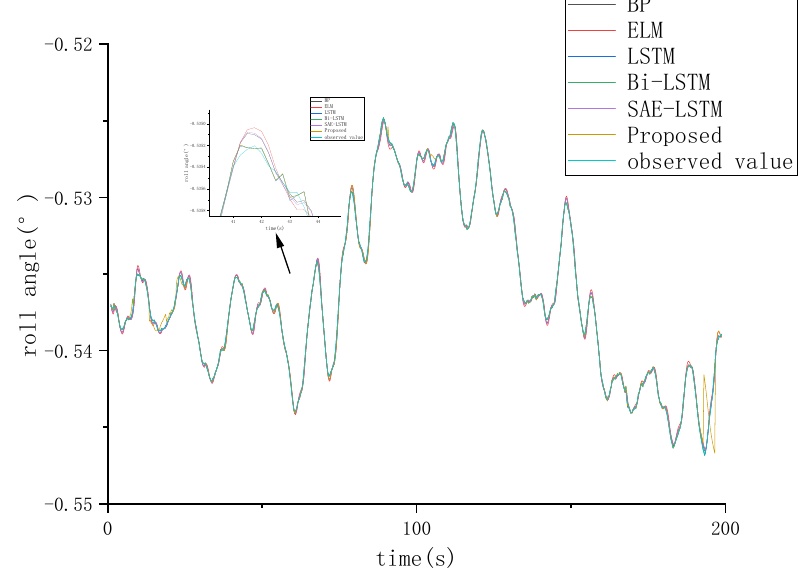
Figure 12. Roll angle prediction results in the training set of Dataset 1.